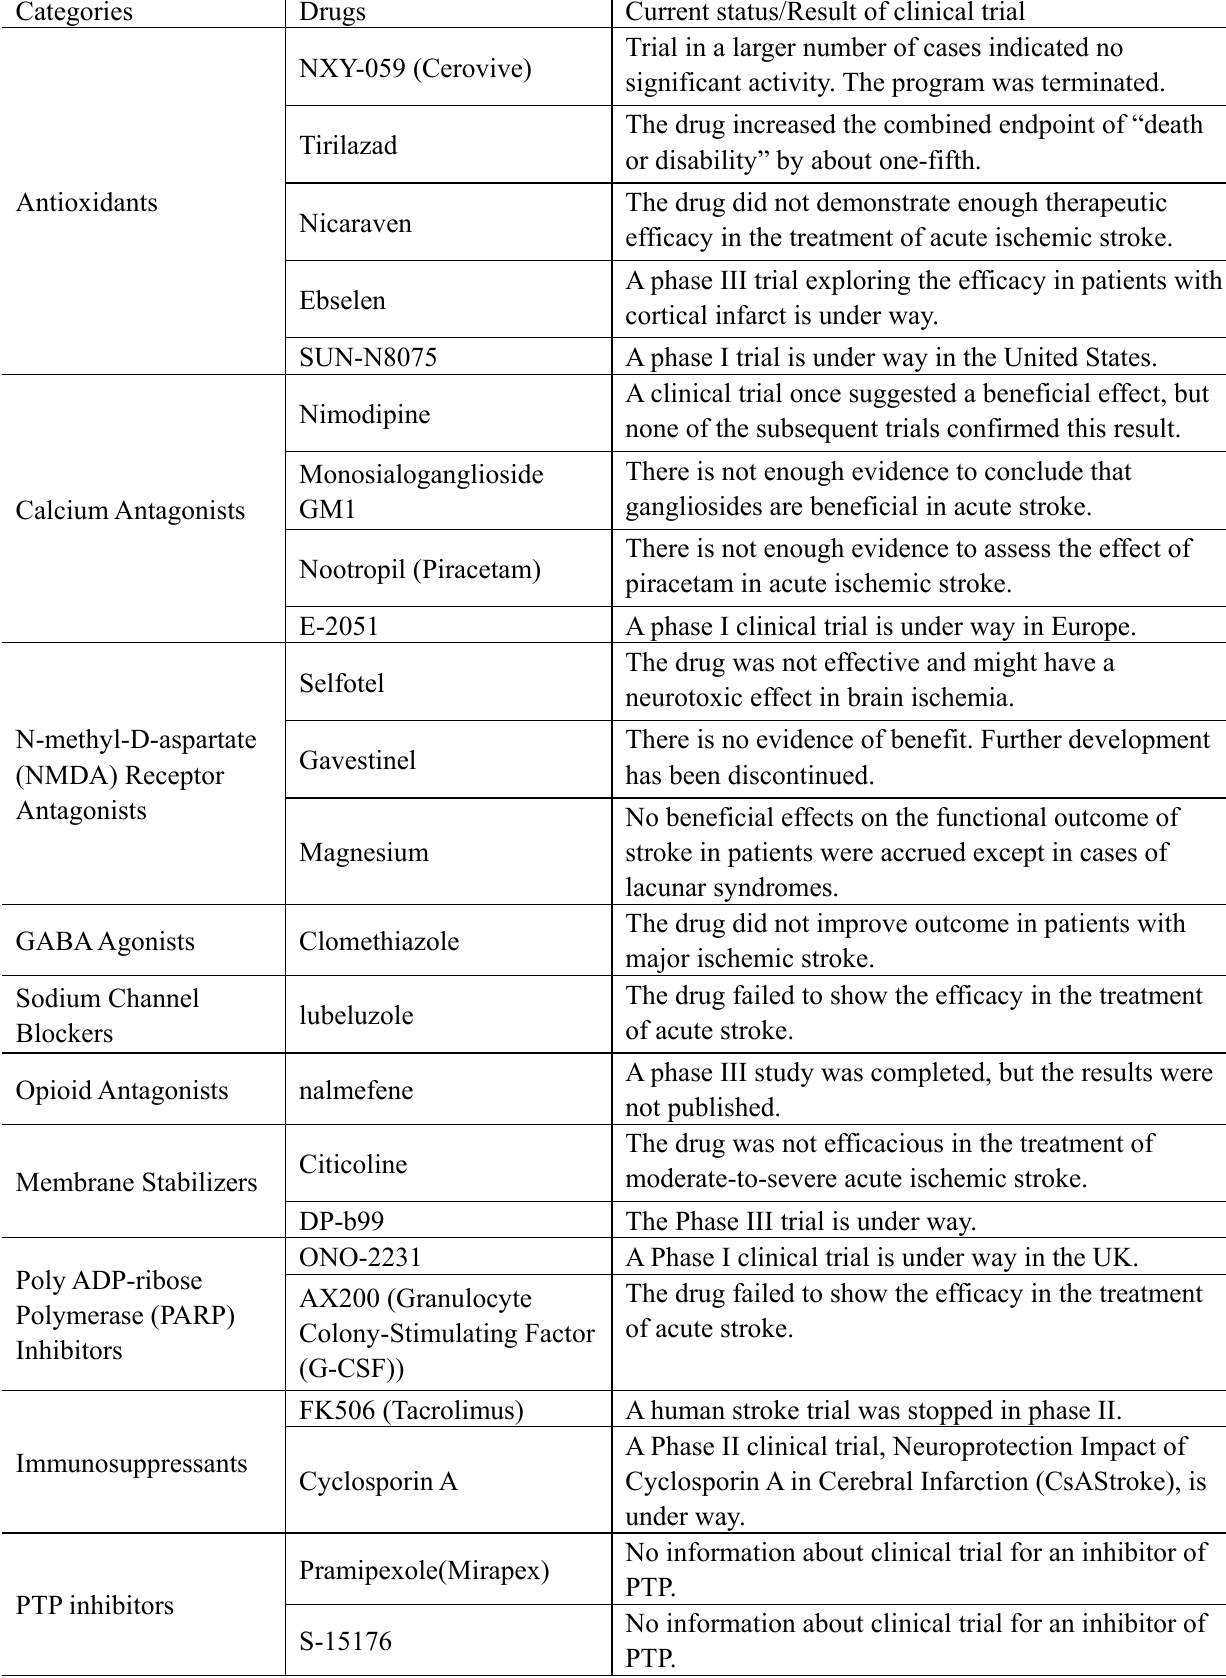
Table 1. Neuroprotective drug candidates and details of their clinical trials.